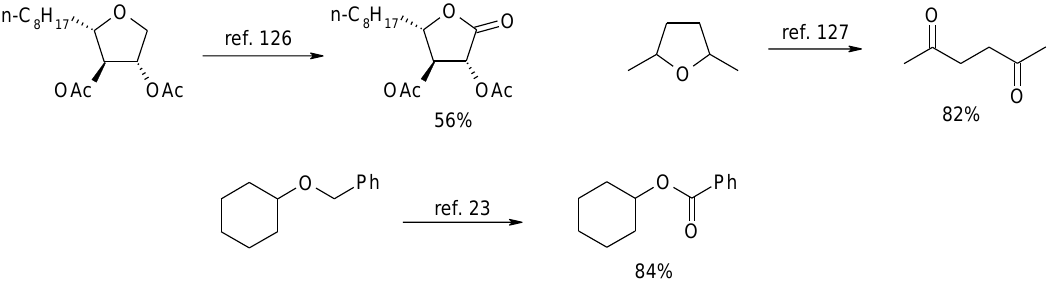
Scheme 30. Representative examples of the RuO